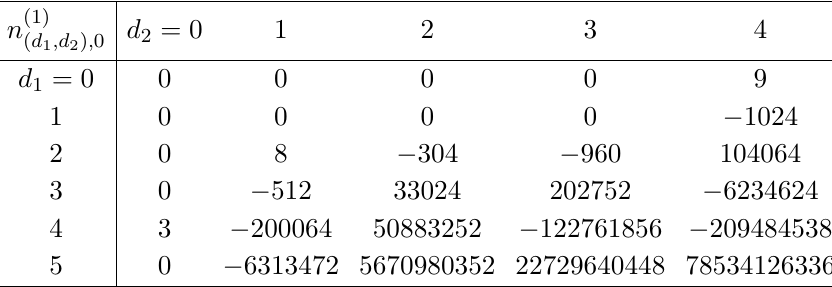
with Z charge 0 . 2 2